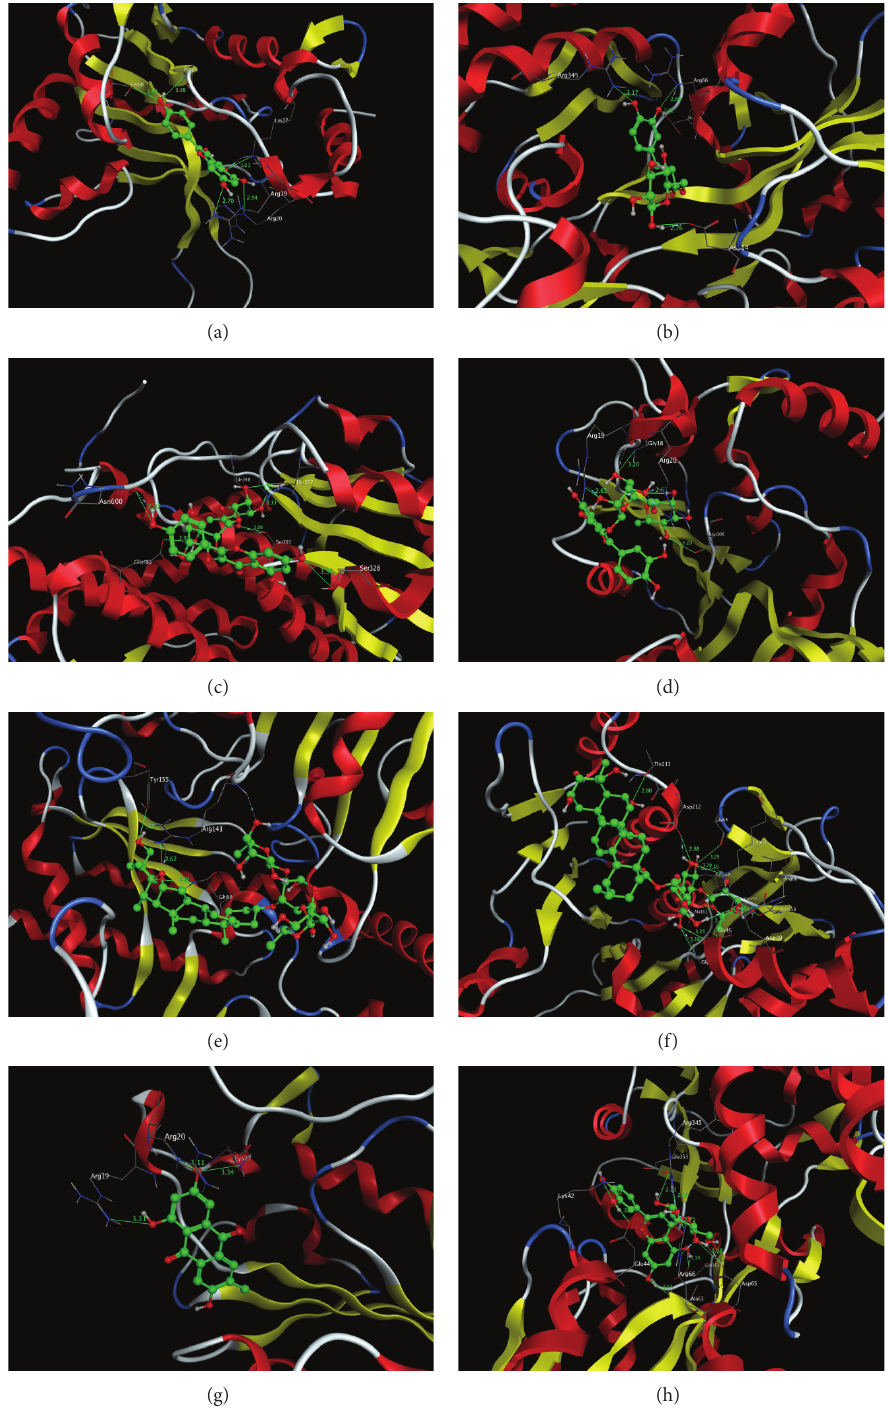
Figure 5: Docking results of Sanjin Tablet compounds into the binding pockets of their targets. (a) Complex of Kaempferol with 2-C- methyl-D-erythritol 4-phosphate cytidylyltransferase (PDB ID 1I52). (b) Complex of 6-O-caffeoyloxy-glucopyranoside with maltose-binding periplasmicprotein(PDBID1JVY).(c)ComplexofKaempferol3-O-rutinosidewithglutamine-fructose-6-phosphateaminotransferase(PDB ID1MOS).(d)ComplexofRutinwith2-C-methyl-D-erythritol4-phosphatecytidylyltransferase(PDBID1I52).(e)Complexoforbiculatoside B with 4-aminobutyrate aminotransferase (PDB ID 1SZS). (f) Complex of Madecassoside with Acetylglutamate kinase (PDB ID 1OHA). (g) Complex of 1,3,8-trihydroxy-6-methylanthraquinone with 2-C-methyl-D-erythritol 4-phosphate cytidylyltransferase (PDB ID 1I52). (h) Complex of Isoquercitrin with maltose-binding periplasmic protein (PDB ID 1JVY). Only the pose of binding pocket was shown for each compound-target complex. Color designations: Sanjin Tablet compounds: green; 𝛼 -helices: red; 𝛽 -sheets: yellow; turns: blue; loops: